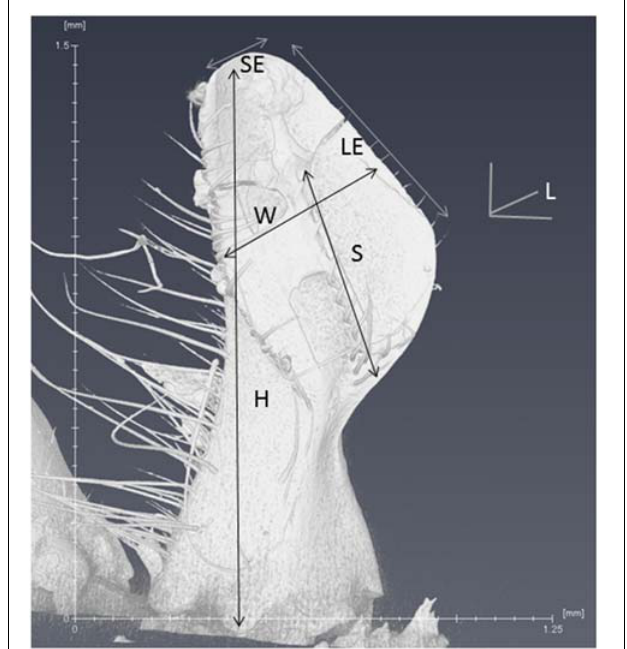
FIGURE 5 | Box plots of the average number of legs missing per mite per colony among two groups, commercial colonies (Comm, N colony = 15) and open-mated mite-biter colonies (open-mated mite biter, N colony = 7). The open circles indicate outliers. The results showed no difference in the average number of legs missing per mite between the two groups, Q = 2.43, p > 0.05.